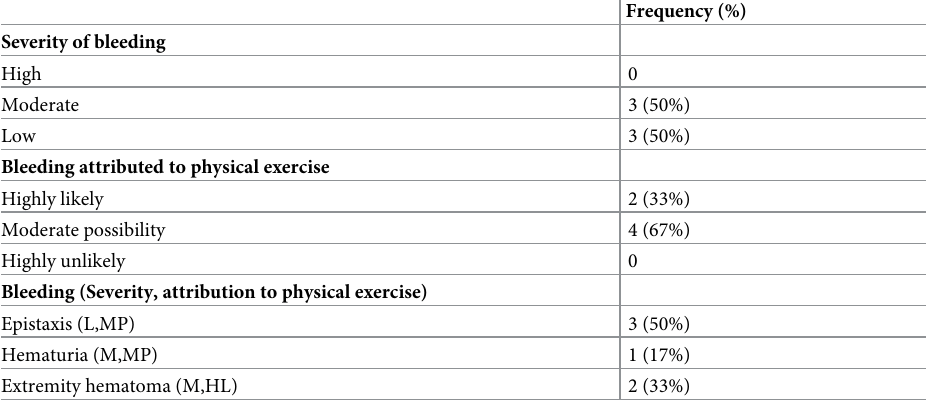
Table 3. Bleeding characteristics, severity, and attribution to physical